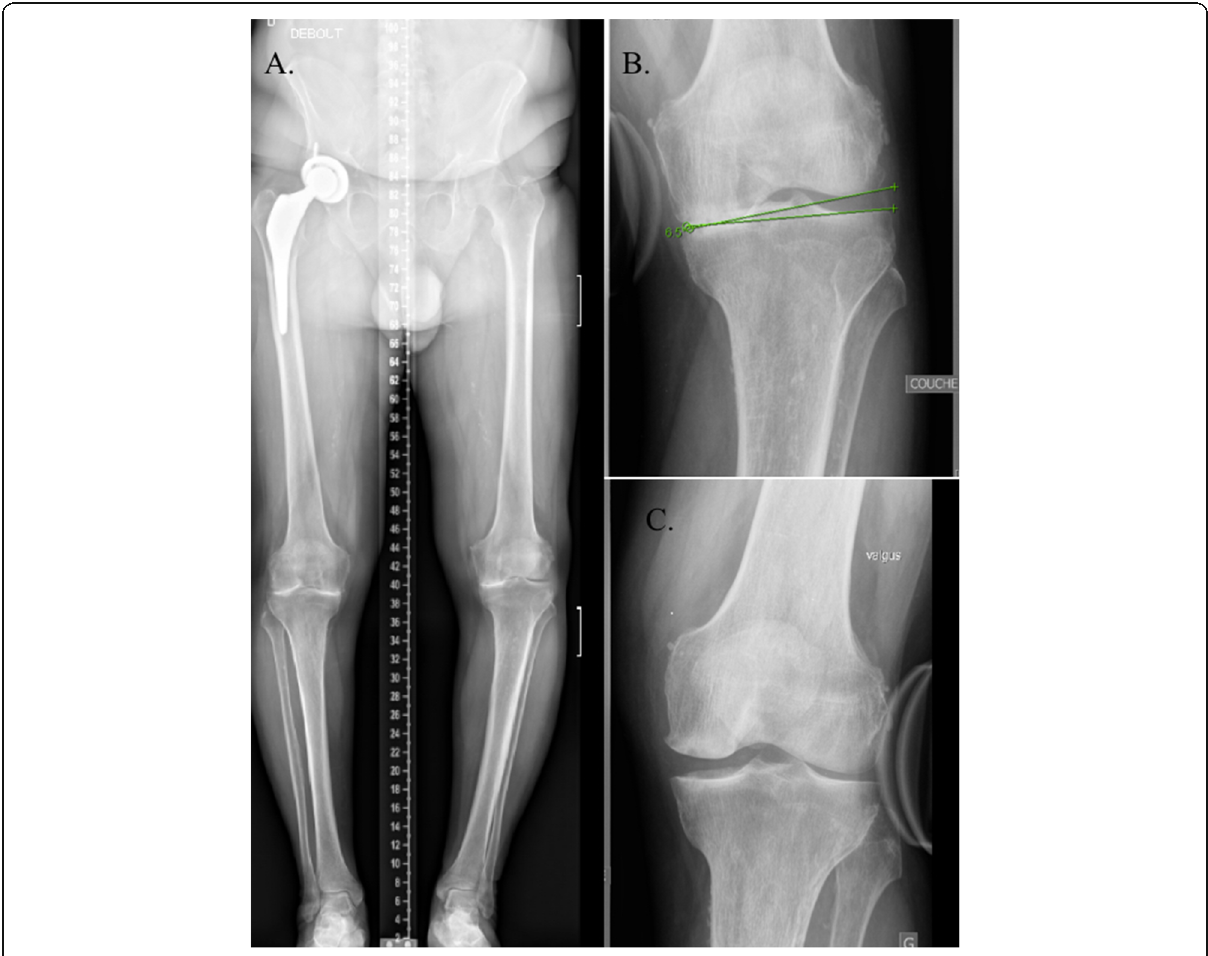
Fig. 4 Preoperative X-rays showing soft tissue imbalance. a . Patient with a preoperative advanced osteoarthritis and assessment of soft tissue imbalance before osteotomy b . Preoperative JLCA under varus stress c . Preoperative JLCA under valgus